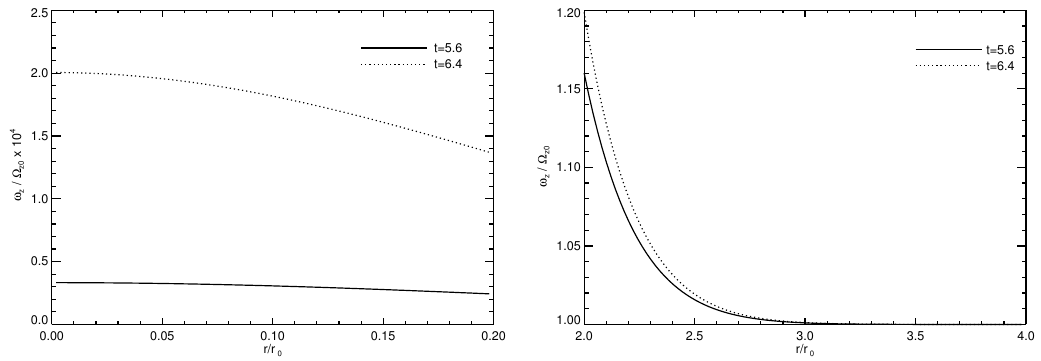
) ] in the inner (left) and the outer 0